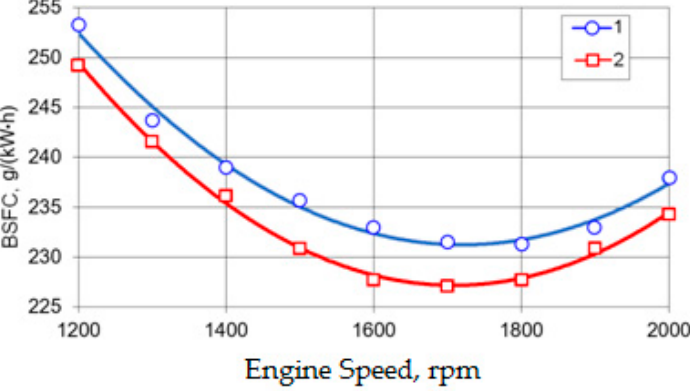
Figure 4. Comparison of the experimental (points) and calculated (lines) values of the specific effective fuel consumption of the engine at the speed characteristic modes: 1—without injection of fuel and water into the intake manifold; 2—with fuel and water injection into the intake manifold. (Source: Authors).